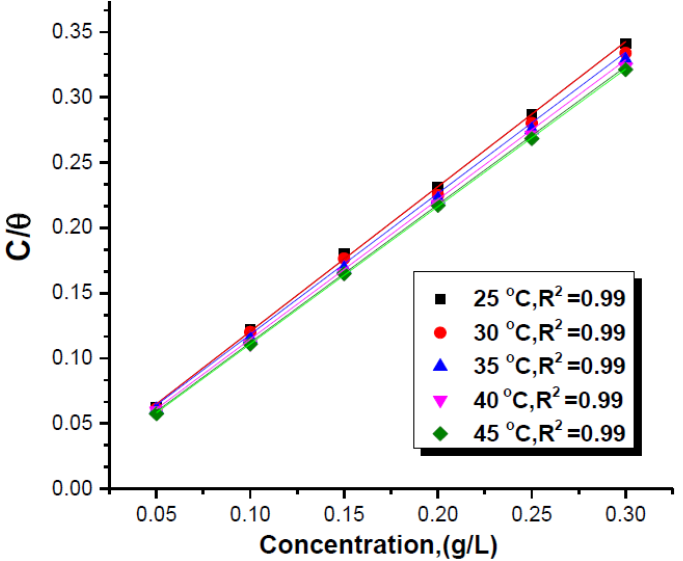
Figure 12. Fitting of Langmuir adsorption for different concentrations for Clinopodium acinos extract. Reprinted from [88].